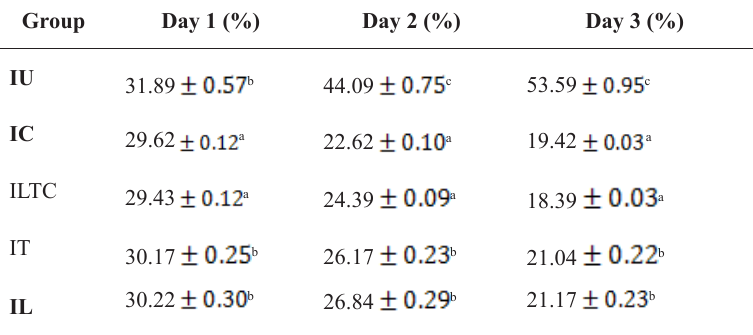
Table 1: Percentage parasitaemia in P. bergei infected mice treated with chloroquine, lumefantrine, trimethoprim, and lumefantrine- trimethoprim-copper complex